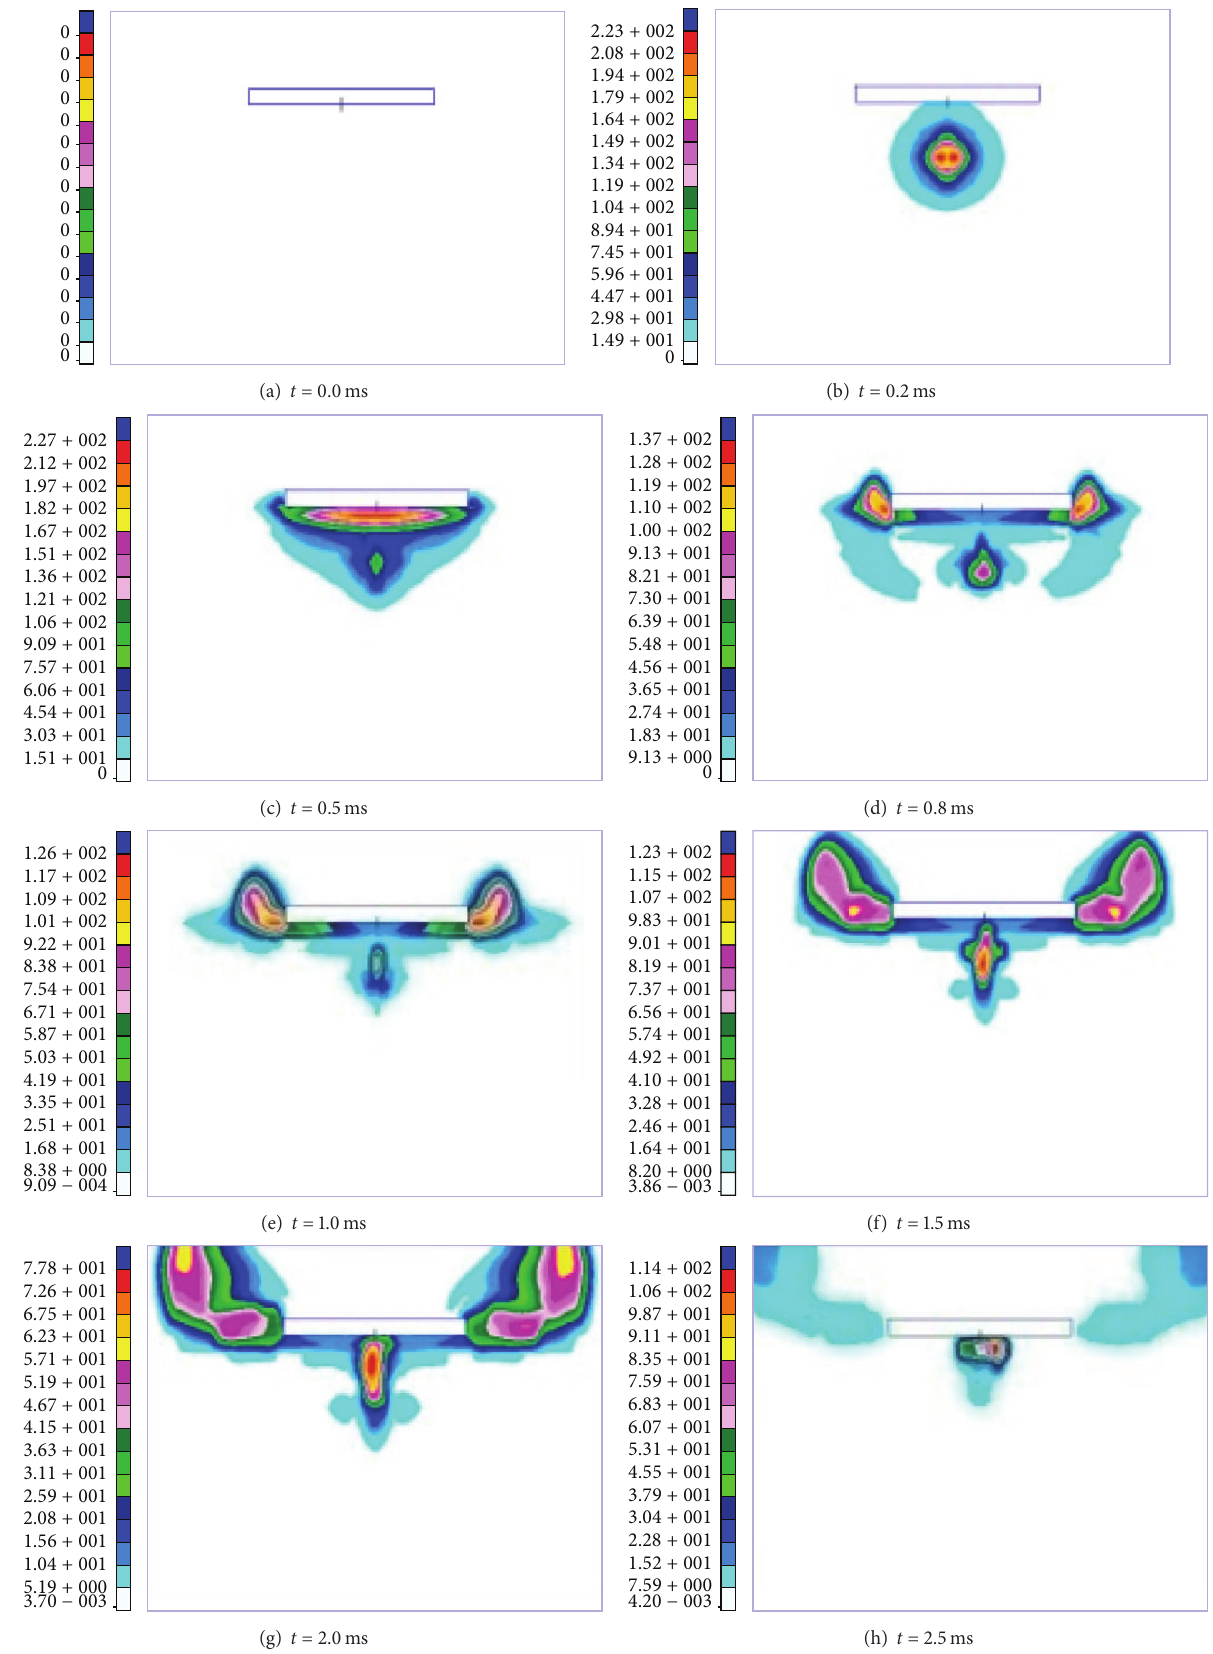
Figure 14: Fluid particle velocity contour ( W = 0.05 kg, d = 0.3